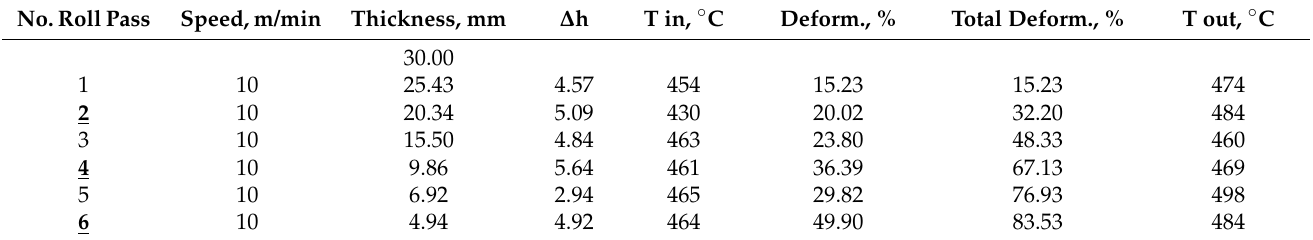
Table 3. Actual rolling parameters of 1565 alloy.